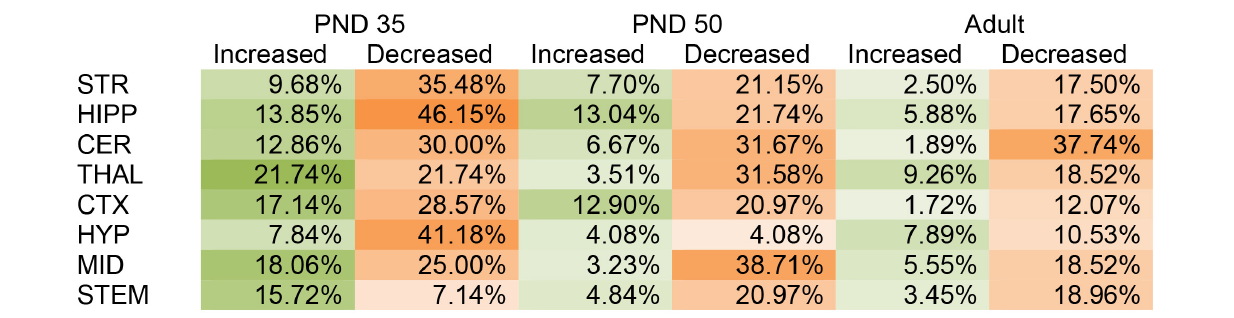
Frontiers in Molecular Neuroscience |